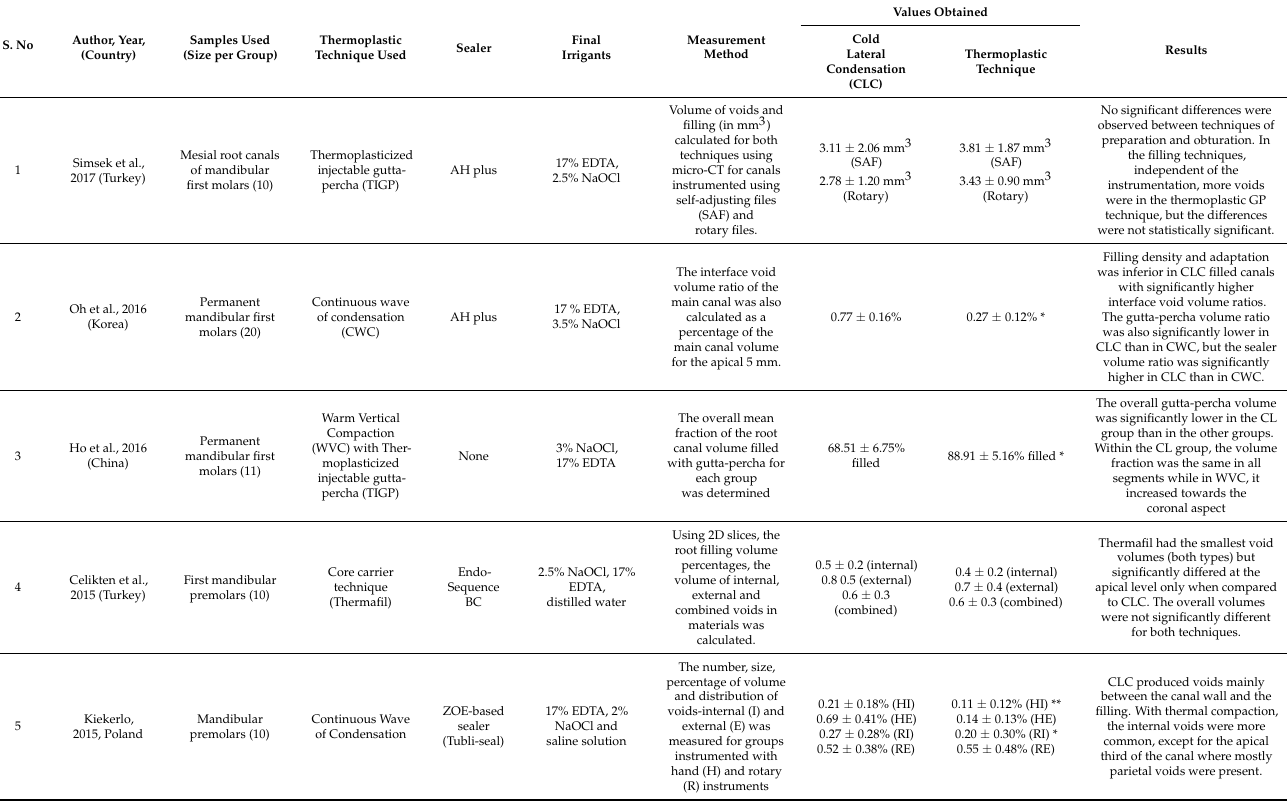
Table 2. Data extracted from selected